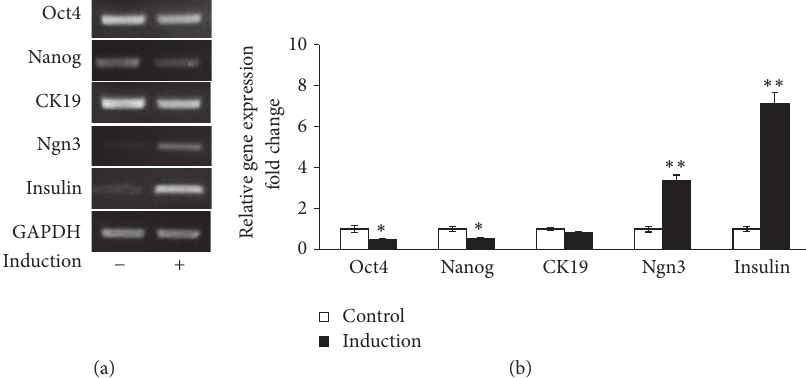
Figure 1: Induction of human pancreatic progenitor cells. (a) Human fetal pancreatic progenitor cells of 10 week were cultured and induced for 1 week. RT-PCR analysis was used to evaluate the markers for stem cell and pancreatic 𝛽 cell in cells before and after 1-week induction. GADPH was used as internal control. (b) Values were expressed as percentage of mRNA expression in cells of induction before (empty bars) and 1-week induction (black bars). Data are means ± SEM of 4 independent experiments per each group. ∗ or ∗∗ , 𝑝 < 0.05 or 0.01.